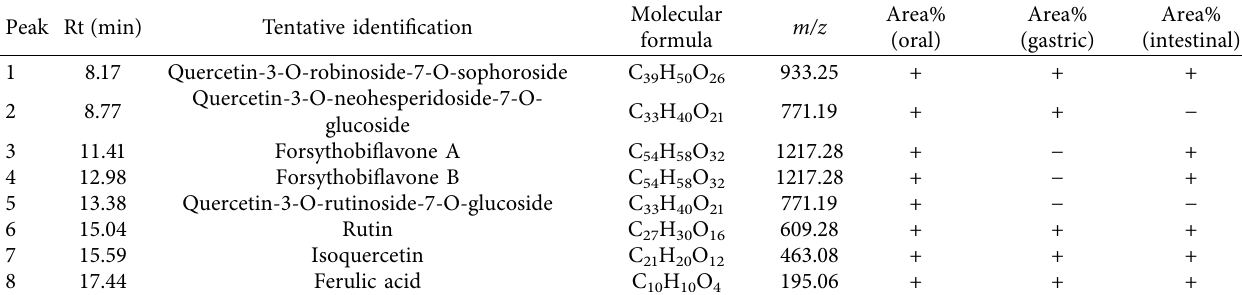
Table 2: Phenolic compounds of the RTBC during in vitro digestion. Peak Rt (min) Tentative identification